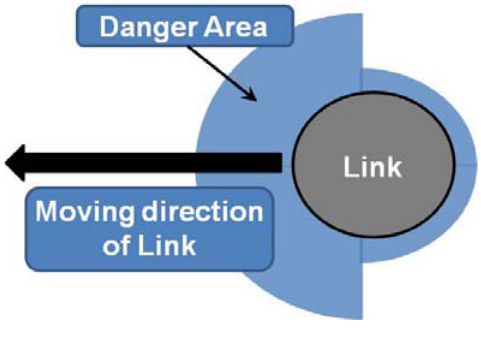
Figure 2. Consideration of moving